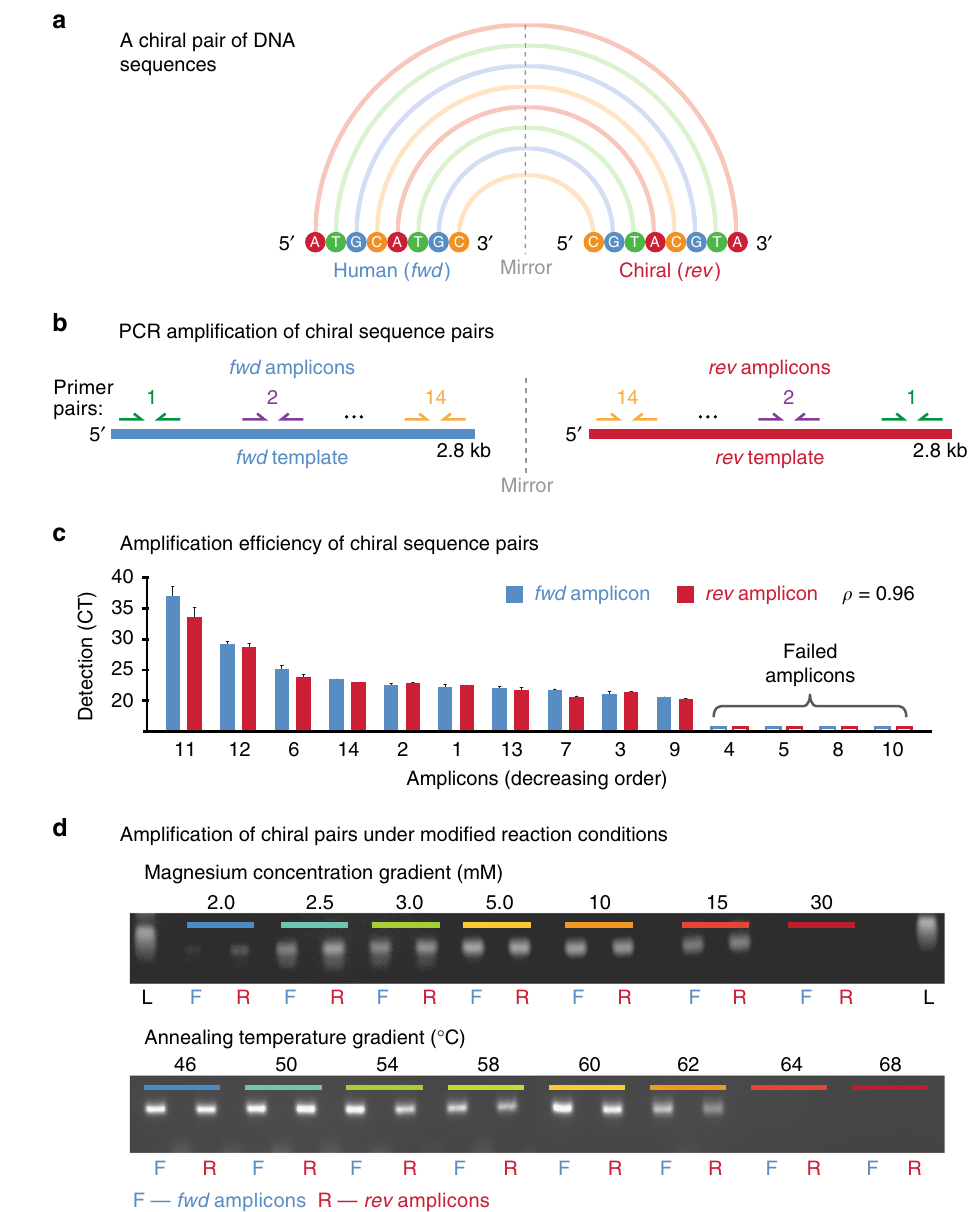
Fig. 1 Matched performance of chiral DNA sequence pairs during PCR ampli fi cation. a Schematic representation of a generic DNA sequence (5 ′ - ATGCATGC) and its mirrored sequence (5 ′ -CGTACGTA) that together form a chiral pair. b Schematic shows PCR primer pairs (colored arrows) targeting intervals within a synthetic human DNA sequence ( fwd ; blue) and mirrored primer-pairs targeting corresponding intervals in the chiral partner sequence ( rev ; red). In total, 14 chiral pairs of PCR amplicons were tested (Supplementary Table 1). c The Bar chart shows ampli fi cation ef fi ciencies for chiral pairs of amplicons, as measured by real-time PCR (detection cycle threshold; CT). Presented values are mean ± standard deviation ( n = 3 ). d Gel electrophoresis images show detection of a single fwd (F; blue) or rev (R; red) amplicon pair ampli fi ed by endpoint PCR over a gradient of magnesium concentration conditions (upper; 0 – 30 mM) or annealing temperatures (lower; 46 – 68 °C). Original gel images are provided as Source Data fi